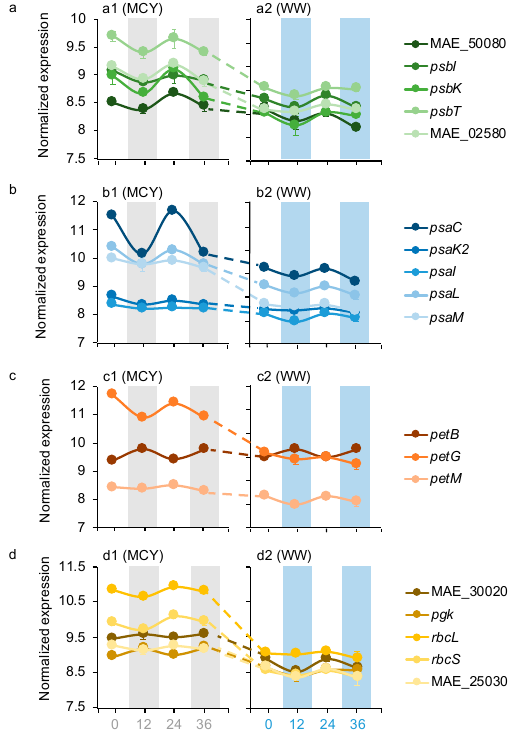
Figure 1. Averages of normalized Microcystis gene expression values based on variance stabilizing transformation in DeSeq2 related to ( a ) PSII, ( b ) PSI, ( c ) cb6f, and ( d ) CBBC in the MCY and WW microcosms. Gray and blue bars indicate dark condition samples in the MCY and WW, respectively. The error bar represents the standard error of gene expression values.